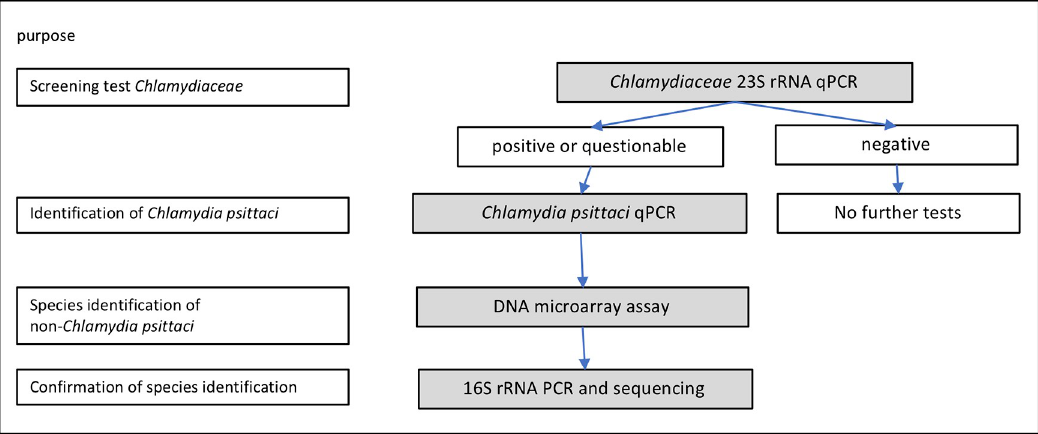
Fig 1. Hierarchical approach for the detection and identification of Chlamydiaceae in cloacal swab samples from turkeys (qPCR = quantitative PCR).